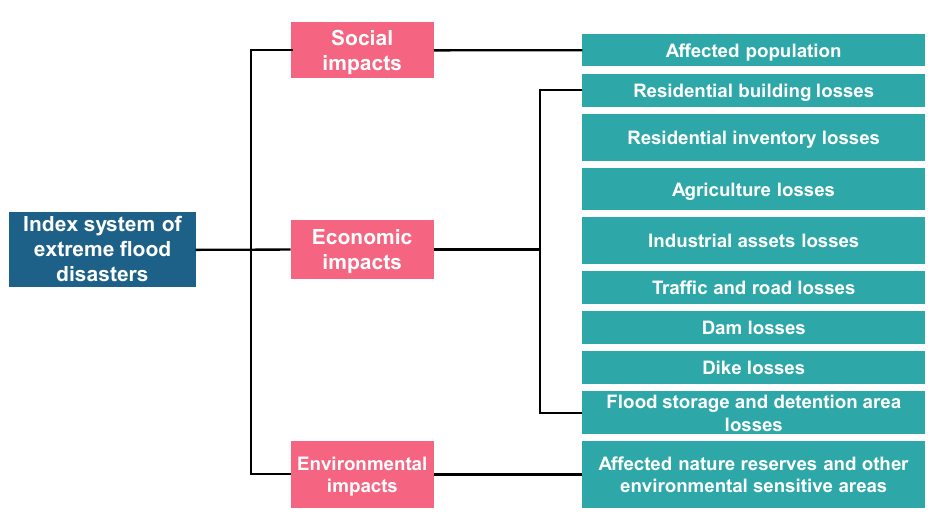
Figure 3. Extreme flood disaster indicator system.